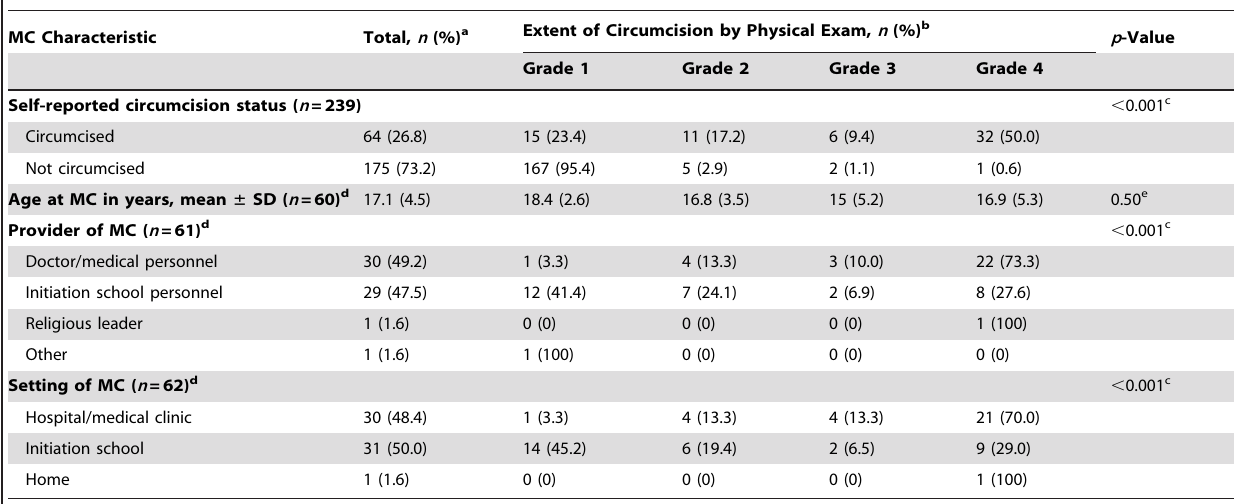
Due to rounding, percentages may not add up to 100. a Column percentages are presented. b Row percentages are presented. c Results of chi-square analysis. d Missing participant responses. e Results of one-way analysis of variance.